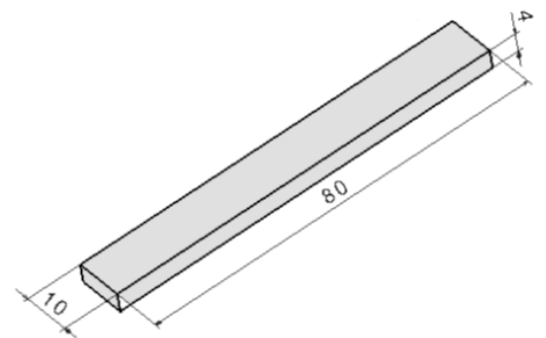
Figure 3. Test sample dimensions (mm). Table 2. Process parameters.